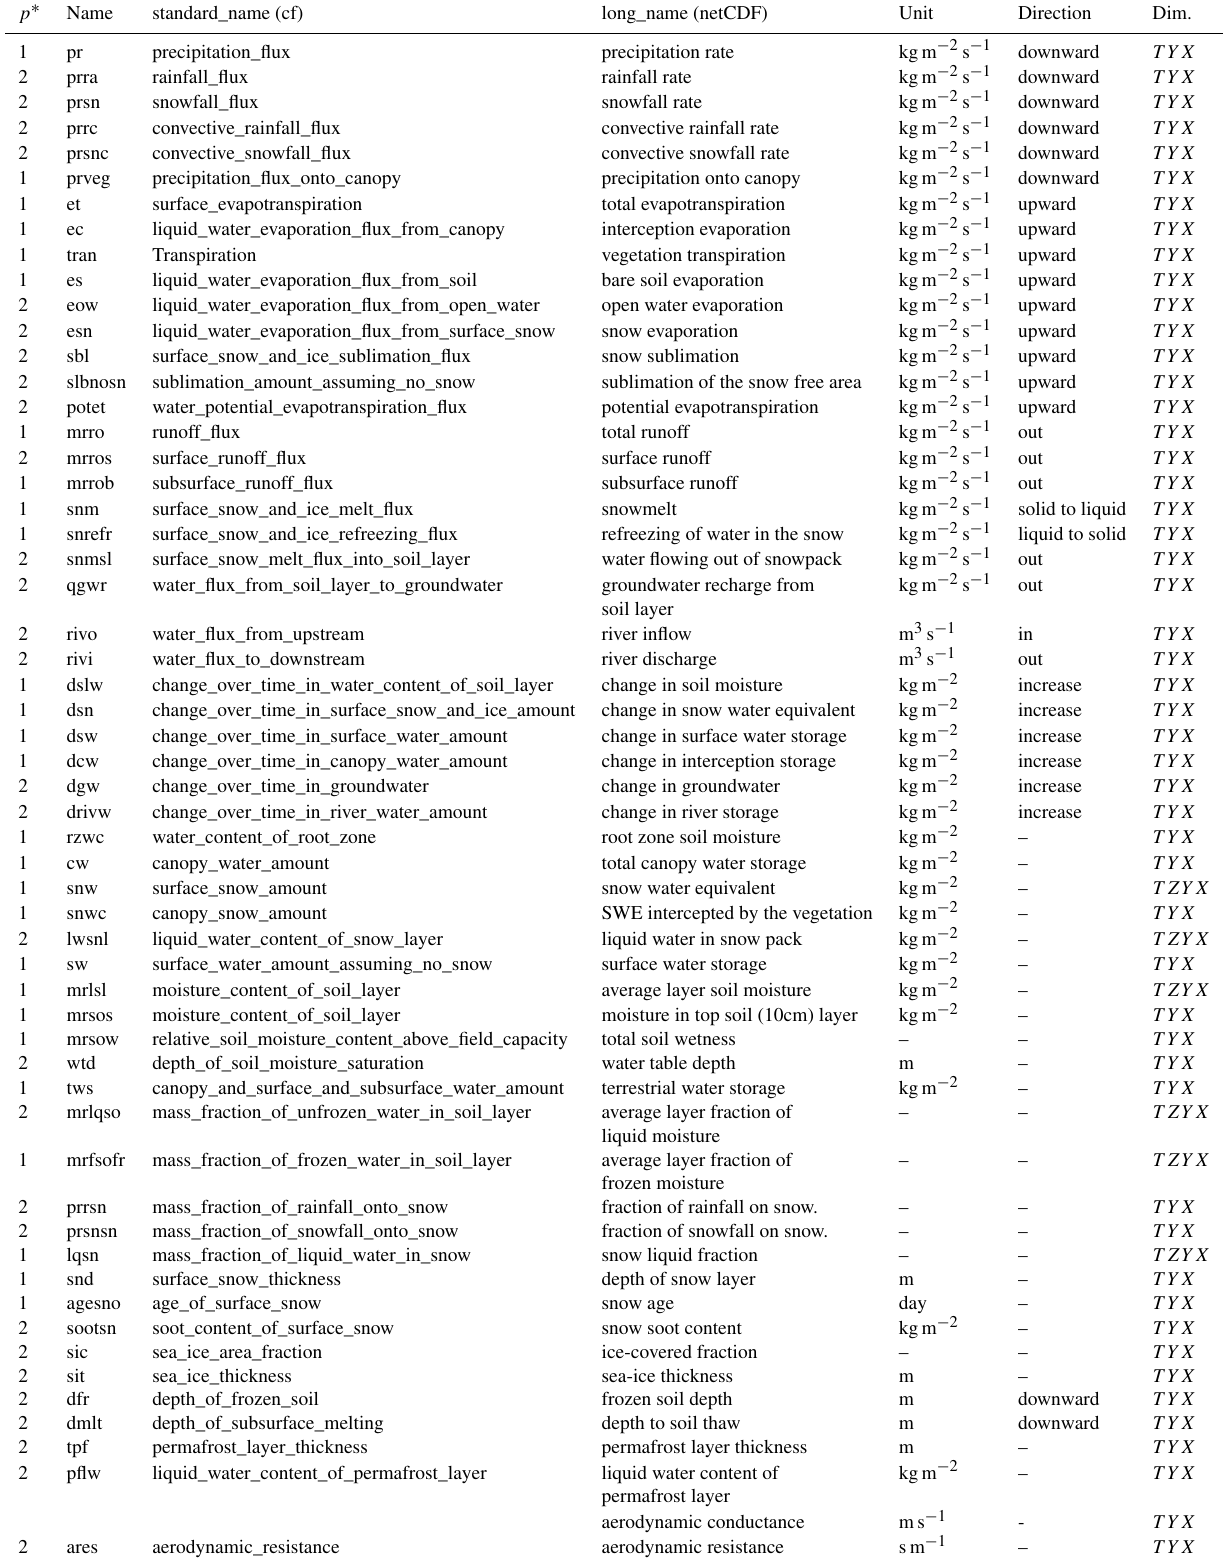
Table A2. Variable request table “LWday”: daily variables related to the water